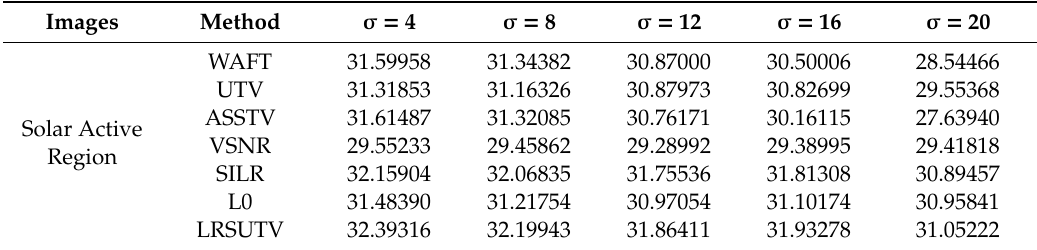
Table 1. PSNR of denoising results in solar active region by various methods for solar active region. Images